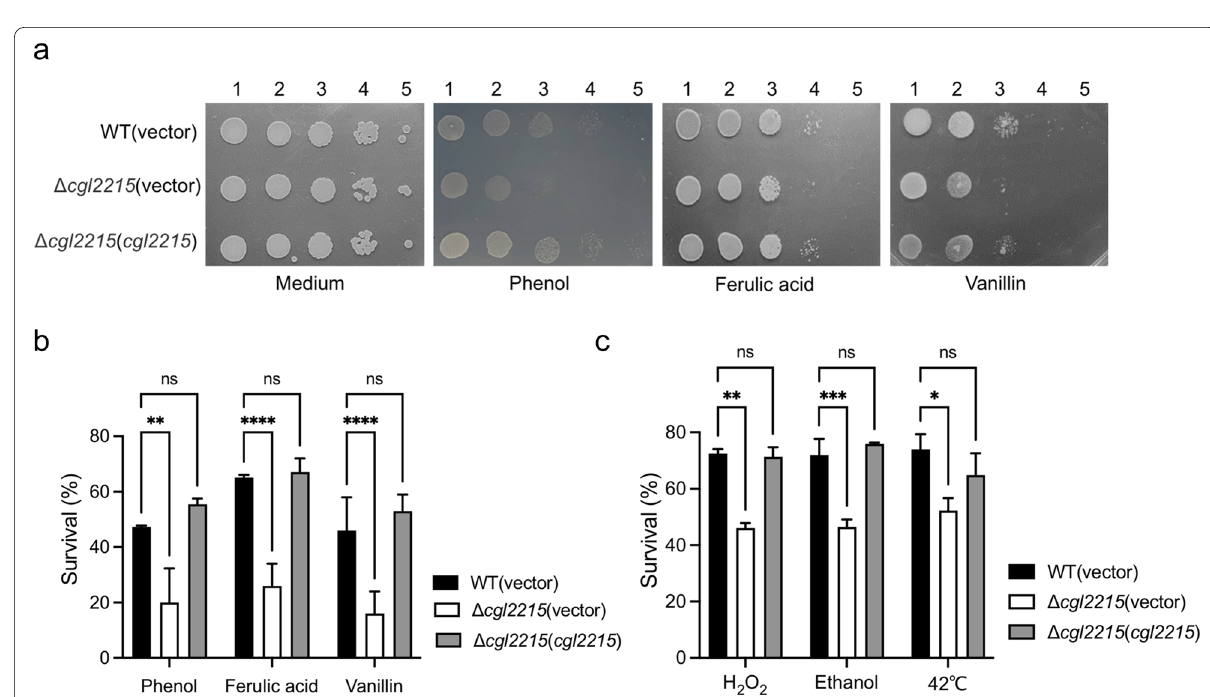
Fig. 2 Effect of cgl2215 deletion on the tolerance to multiple environmental stresses in C. glutamicum . a Estimation of C. glutamicum tolerance to phenol (32 mM), ferulic acid (5 mM), or vanillin (20 mM) by LB agar-plate culture. b Survival rates of C. glutamicum strains after exposure to phenol (50 mM), ferulic acid (8 mM) or vanillin (50 mM) stresses for 30 min. c Survival rates of C. glutamicum strains after exposure to H 2 O 2 (20 mM), ethanol (1.72 M), or heat (42 °C) stresses for 30 min. The mean values and SD from at least three repeats are shown. * P < 0.05; ** P < 0.01; *** P < 0.001; **** P